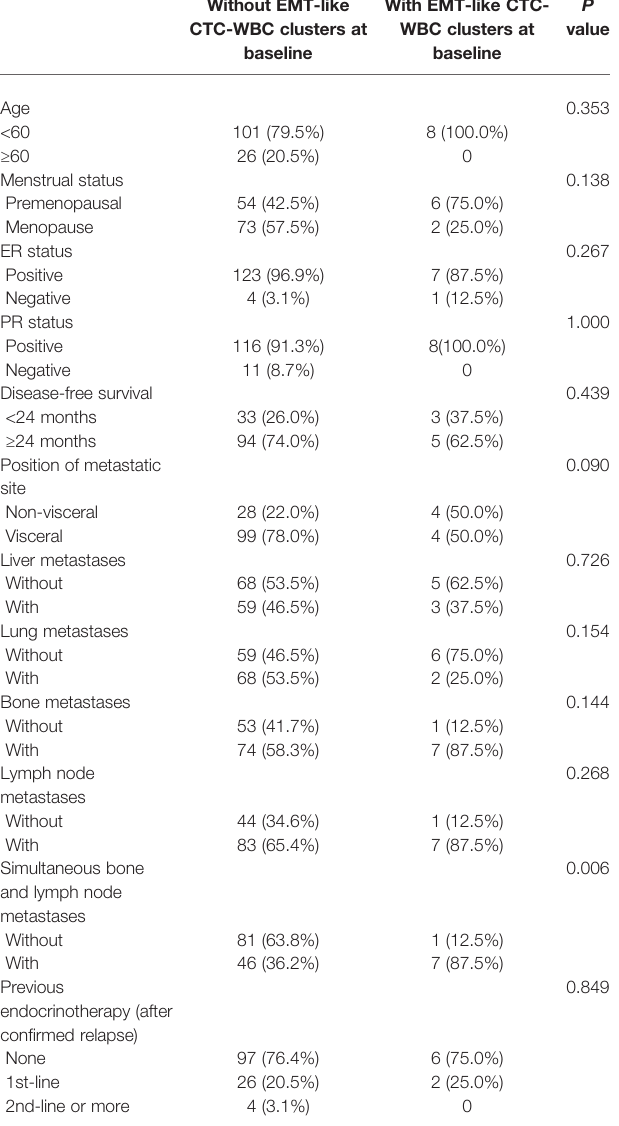
TABLE 2 | The association between the presence of EMT-like CTC-WBC clusters and the clinicopathological characteristics of 135 enrolled patients with HR-positive/HER2-negative metastatic breast cancer undergoing docetaxel plus capecitabine as fi rst-line chemotherapy. Without EMT-like CTC-WBC clusters at